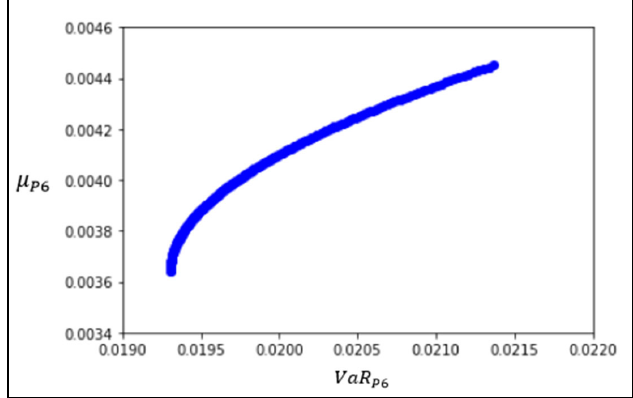
Fig. 2. Efficient Frontier of P6